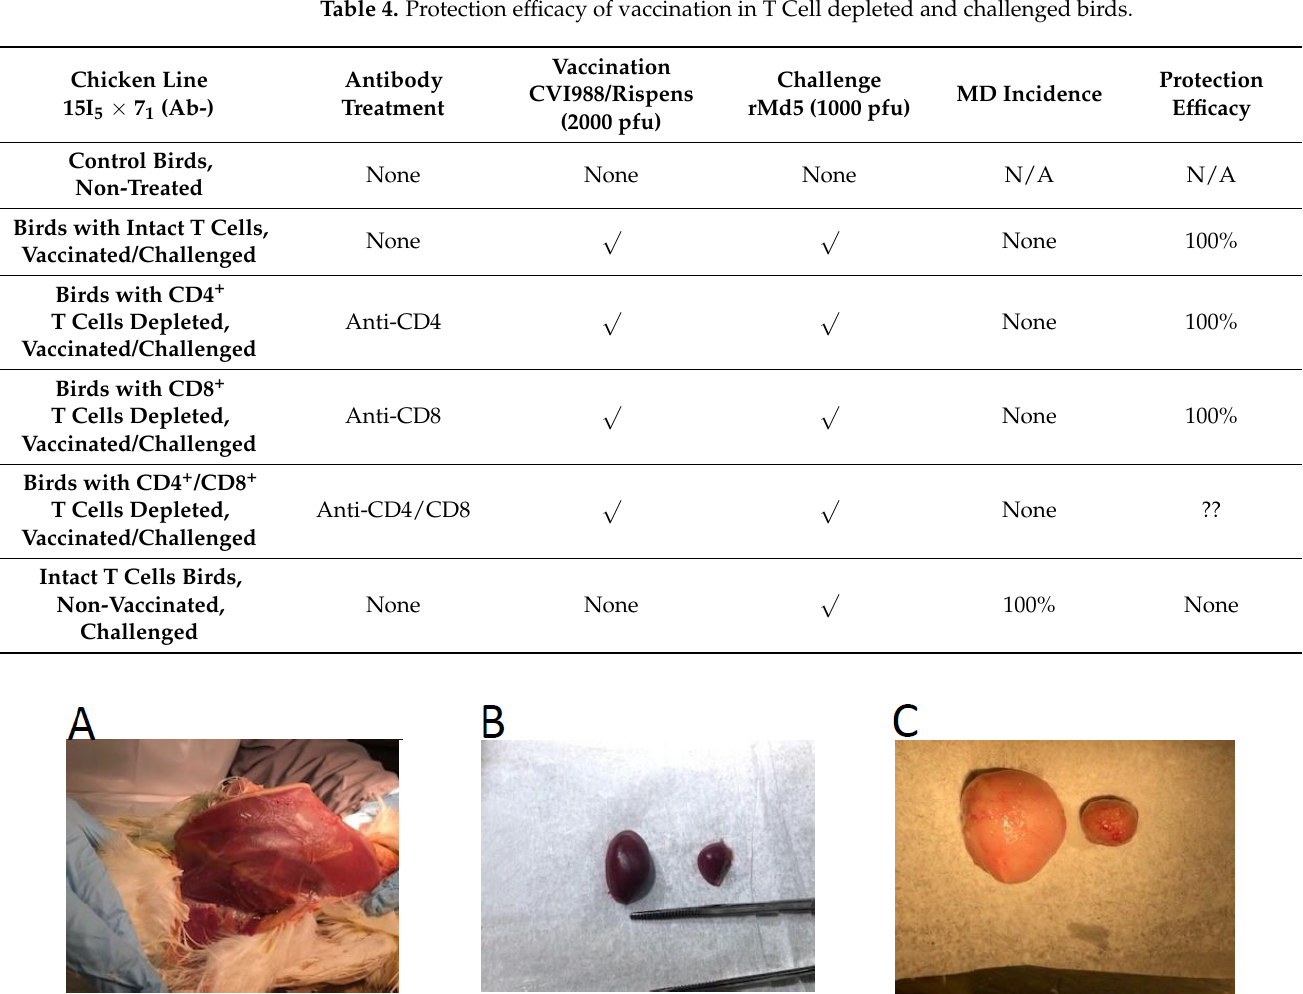
Figure 7. The picture depicts the chest bone (keeled sternum) of a CD4 + /CD8 + T cell depleted bird that is severely emaciated ( Panel A ). These birds exhibit no clinical signs of MD during the experiment and no T cell lymphoma at termination. The birds experienced breathing difficulties. ( Panel B ) shows the spleen of a CD4 + /CD8 + T cell depleted bird at termination. Left: spleen from a CD4 + T cell depleted bird; right: spleen from CD4 + /CD8 + T cell depleted bird. This contrasts with MDV-infected birds where the spleen is enlarged (splenomegaly), and the thymus and bursa are atrophied. ( Panel C ) depicts the bursa of a CD4 + /CD8 + T cell depleted bird. Although the spleen tissues from these birds were negative for MDV genome, the bursas, like the spleens, were severely atrophied. Left: bursa from a CD4 + T cell depleted bird; right: bursa from a CD4 + /CD8 + T cell depleted bird.